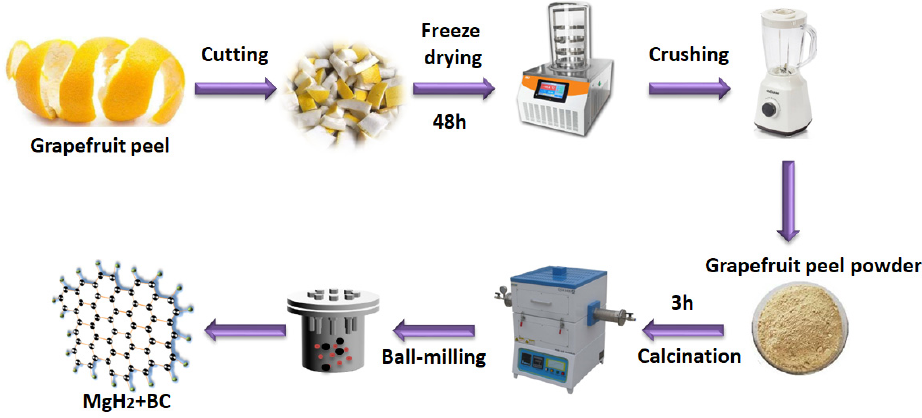
Figure 1. Schematic diagram of synthesis process of MgH 2 + BC composite.